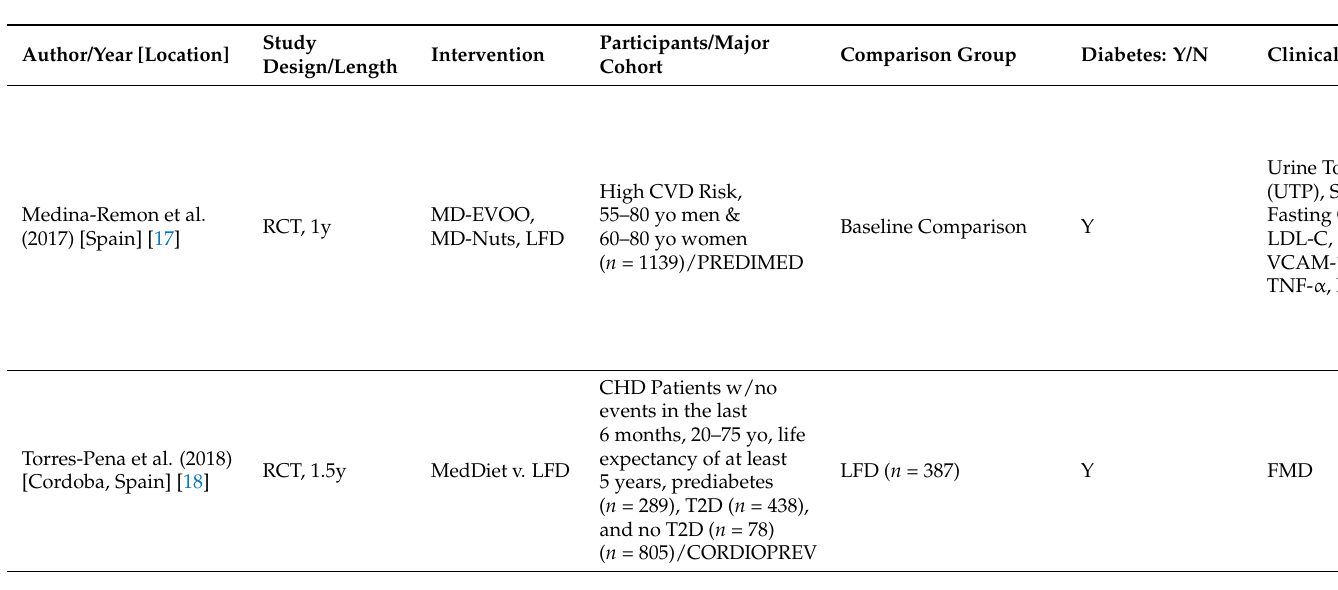
Table 2. Clinical Studies.